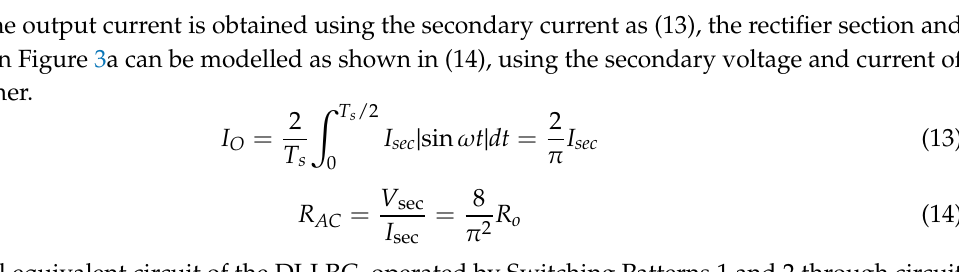
Figure 5. Voltage and current waveforms at the secondary side.